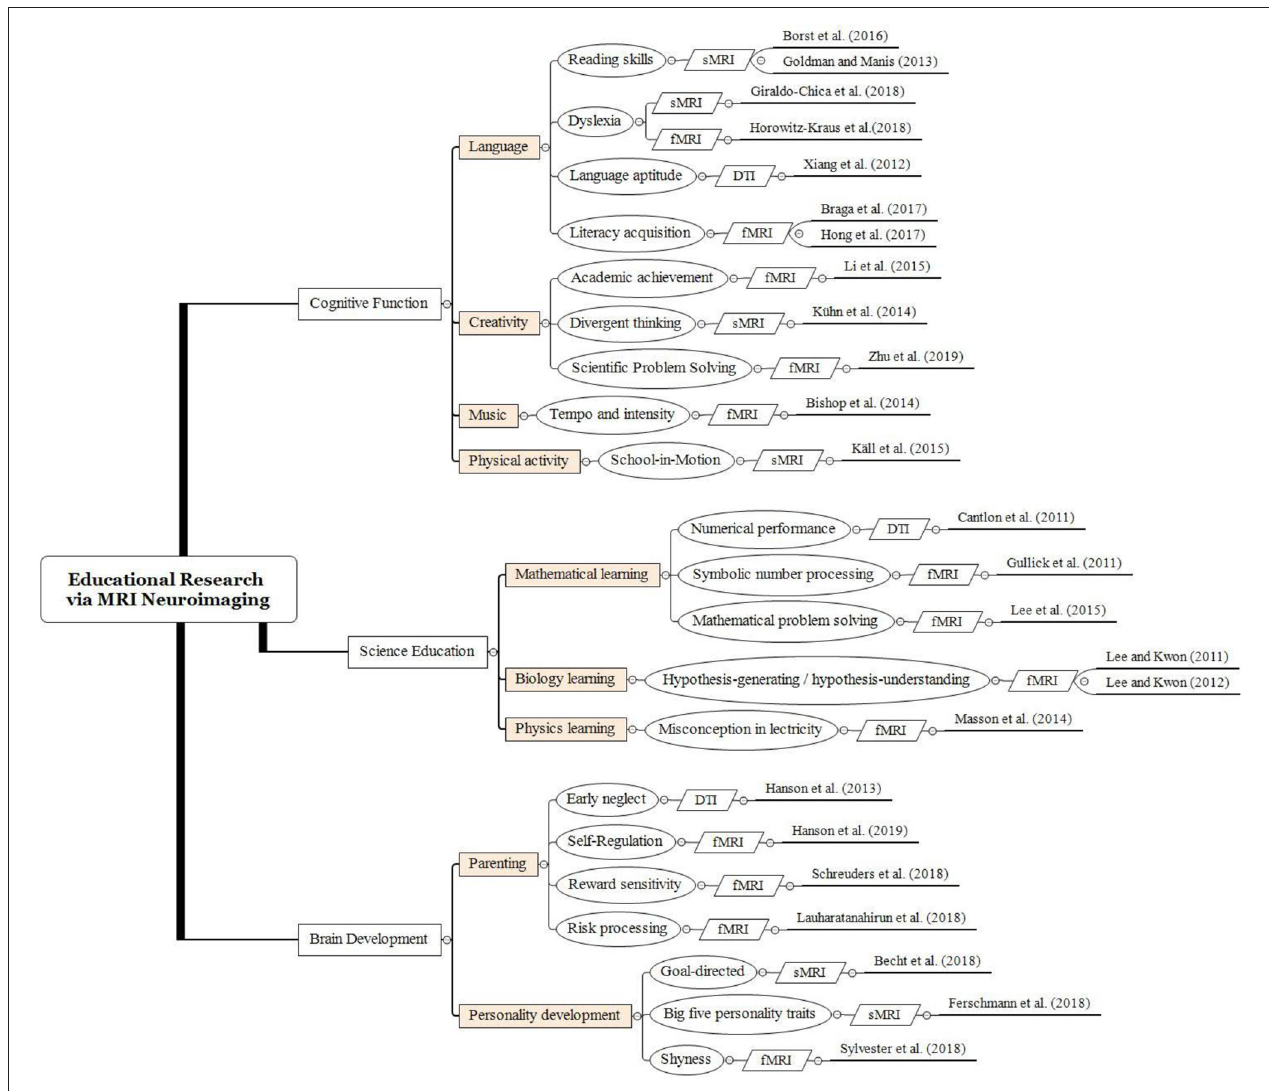
FIGURE 1 | Educational research via MRI neuroimaging in the reviewed studies.